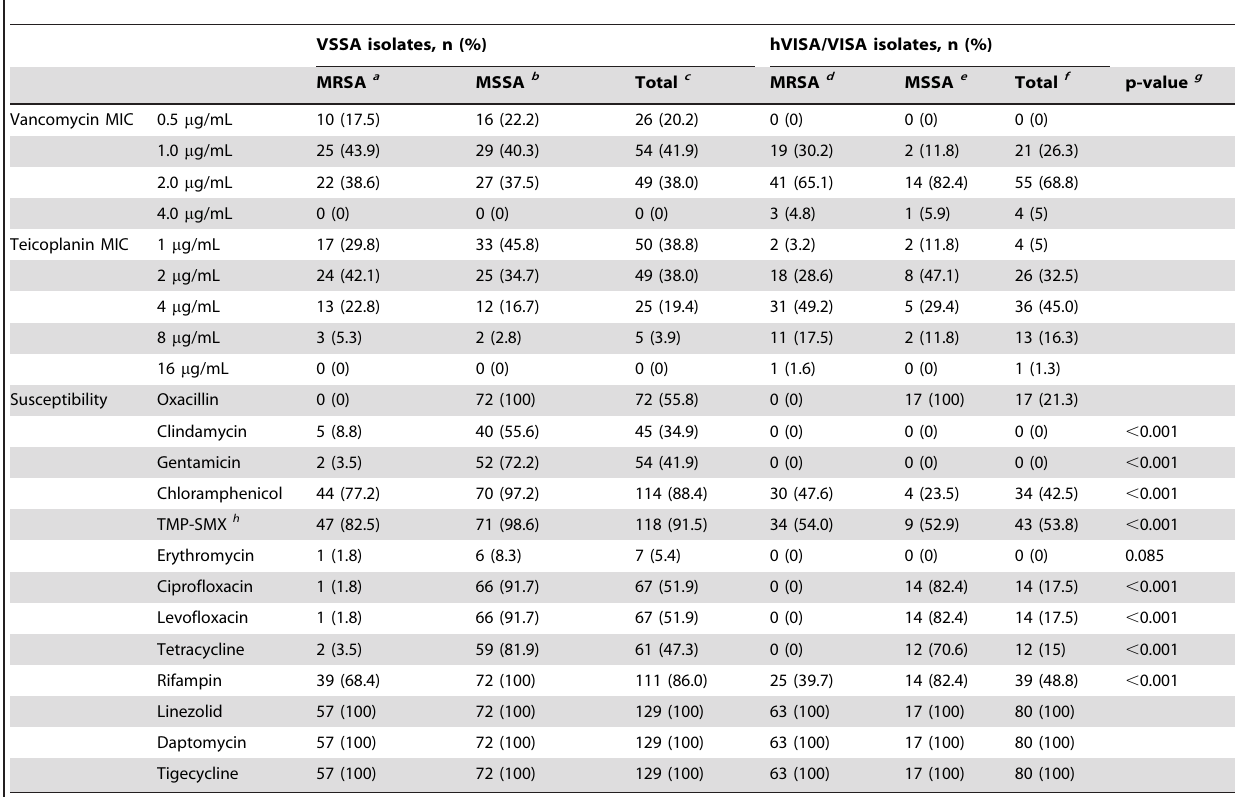
Table 2. Antimicrobial activity of 15 antimicrobial agents against 209 screen-positive isolates in vitro .